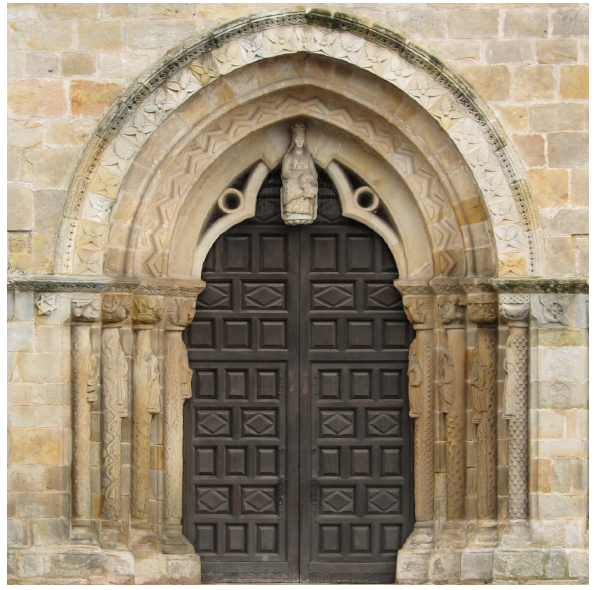
Figure 2: Ortoimage generated from the virtual model with ap- pearance capture simulating completely overcast sky. Shadows are very diffuse and there is limited volumetric appreciation.